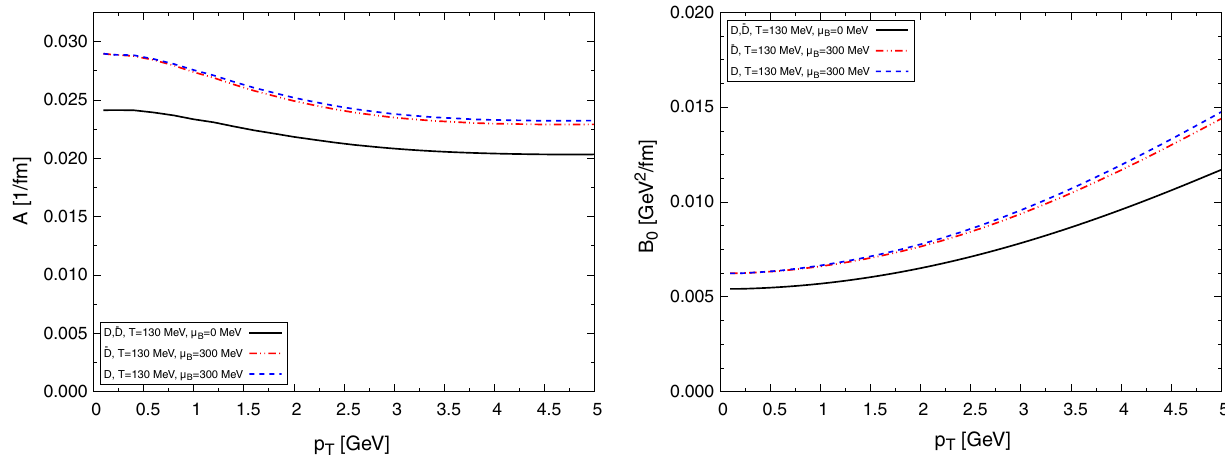
Fig. 6 Drag (left) and diffusion (right) coefficients at different temperatures for D and ¯ D mesons, taking into account a fugacity factor